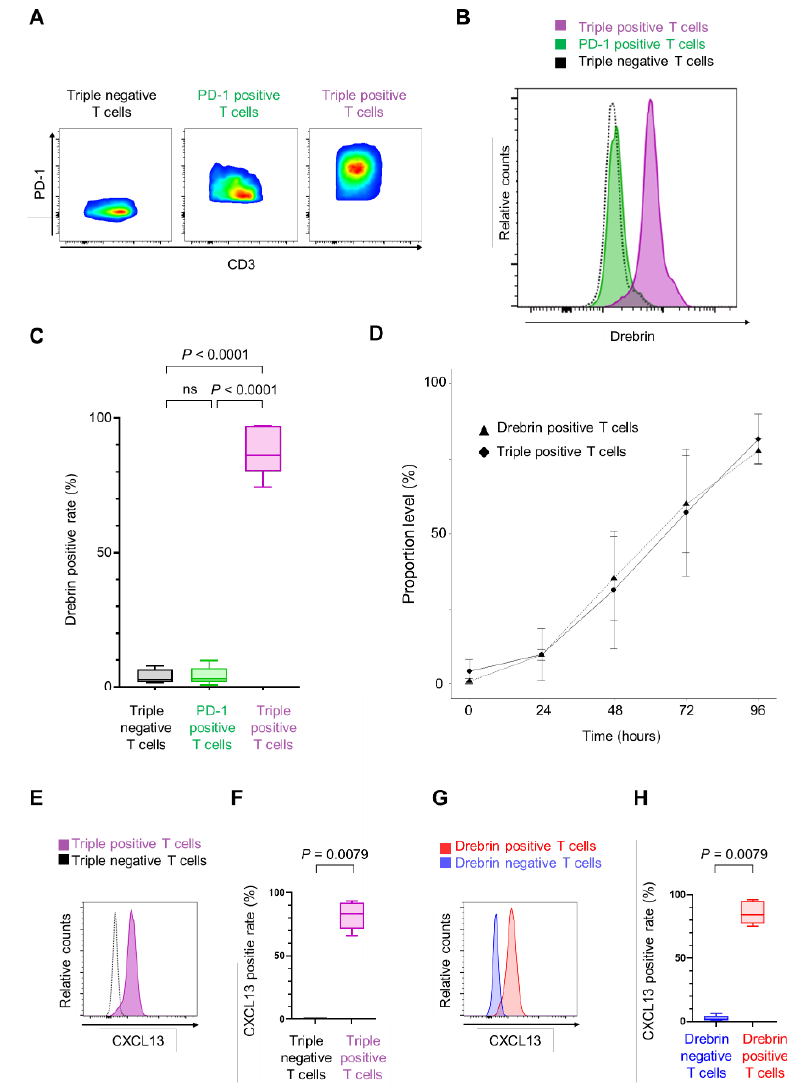
Figure 5. Drebrin + T cells co-express multiple exhaustion-associated molecules. ( A ) Representative flow cytometry plots of three populations. Triple-negative T cells are negative for PD-1, TIM-3, and LAG-3. PD-1 positive T cells are positive for PD-1 but negative for TIM-3 and LAG-3. Triple-positive T cells are positive for PD-1, TIM-3, and LAG-3. Cells were cultured for 96 h. ( B ) Representative histograms of each population. ( C ) Frequencies of drebrin + T cells among each population. ( D ) A correlation between drebrin expression in T cells and triple-positive T cells under in vitro culture conditions. Cells were cultured for up to 96 h. ( E ) Representative histograms of triple-positive or triple-negative T cells. ( F ) Frequencies of CXCL13 + T cells among each population. Cells were cultured for 96 h. ( G ) Representative histograms of drebrin-positive or drebrin-negative T cells. ( H ) Frequencies of CXCL13 + T cells among each population. Cells were cultured for 96 h. CXCL13, chemokine ligand 13; LAG-3, lymphocyte activation gene 3; PD-1, programmed cell death-1; TIM-3, T cell immunoglobulin- and mucin-domain-containing protein 3.